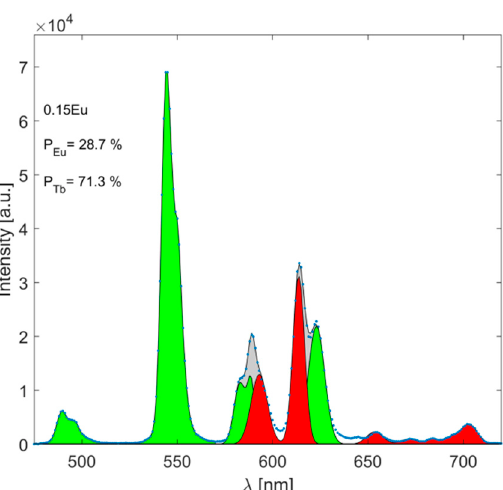
Figure 6. Deconvolution to the experimental emission spectrum (blue). Red and green areas represent the emissions related to the Eu 3+ and Tb 3+ ions, respectively.